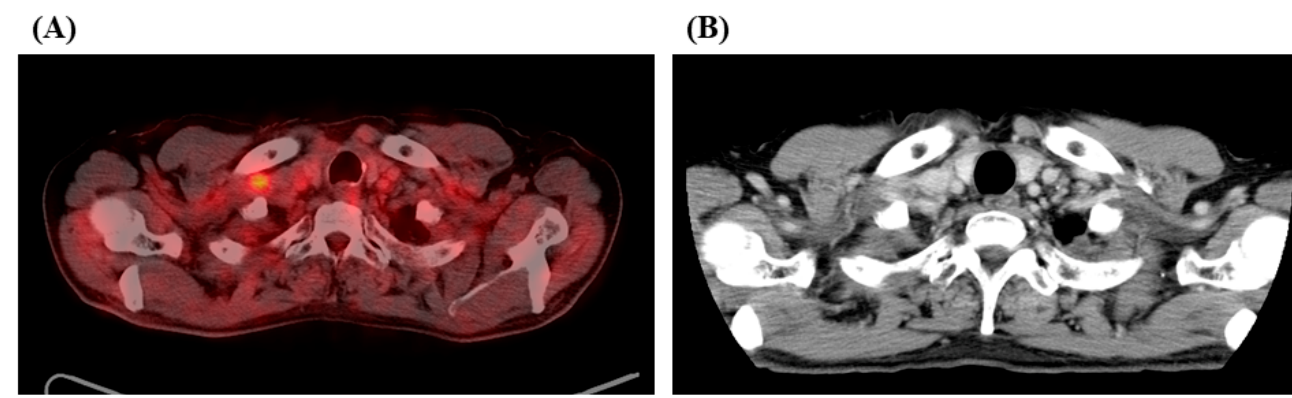
Figure 1. 18 F-fluorodeoxyglucose (FDG) positron emission tomography/computed tomography (CT) obtained 2.5 years after definitive chemoradiotherapy ( A ) demonstrated a right supraclavicular lymph node swelling with a maximum standardized uptake value of FDG scoring 3.3. Contrast-enhanced CT ( B ) showed a right supraclavicular lymph node swelling of 7.4 mm in shorter diameter.